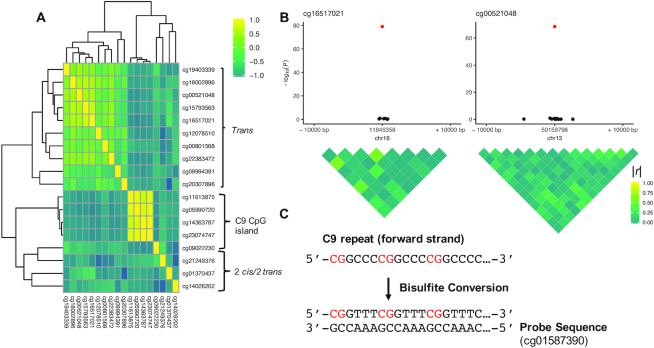
(A) Heatmap showing the correlations between the 18 CpGs that were significantly associated with C9 status. Correlations were calculated within carriers of the C9 expansion. Probes are annotated with their respective positions: the upper cluster consists of 10 probes in trans (>100 kb) of the C9 repeat, the middle cluster consists of four probes located in the CpG island upstream of the repeat, and the lower cluster consists of two trans probes and two cis probes. (B) Locus plots of the two most significant trans CpGs. There are no regional effects in the trans associations. Locus plots for all trans probes are shown in Supplementary Figure S2. (C) Example of the C9 GGCCCC hexanucleotide repeat after bisulfite conversion (forward strand shown), where we assumed that the repeat is fully methylated (43). The probe sequence of one of the trans CpG-sites (cg01587390) is displayed, showing that the 3′ end of the probe partially matches the bisulfite-converted C9 repeat.